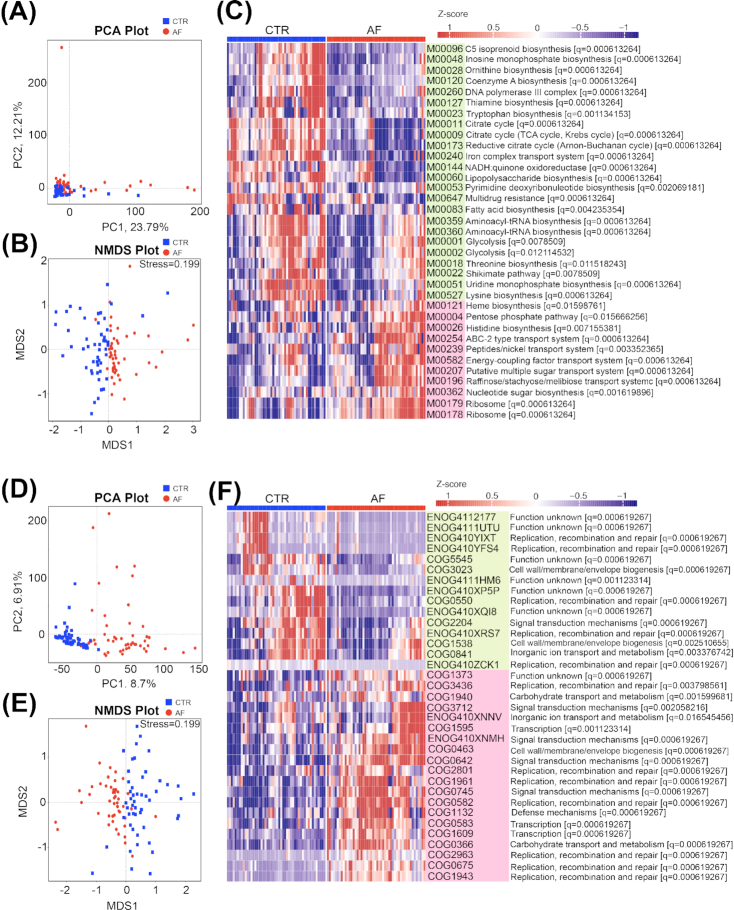
Microbial gene function annotation in AF. A and B, PCA (A) and NMDS (B) based on the relative abundance of KEGG orthology groups in 100 samples showed a significant difference between AF and control (CTR). C, The meanabundance of KEGG modules differentially enriched in the GM of controls and patients with AF. The relative abundance profiles were transformed into z scores by subtracting the mean abundance and dividing the standard deviation of all samples. The z score is negative (shown in blue) when the row abundance is lower than the mean, and red when the row abundance is higher than the mean. Overall, 24 modules enriched in control and 11 modules overrepresented in AF are shown in green and pink, respectively. The physiological effect of KEGG modules and q value are demonstrated on the right; Wilcoxon rank sum test. D and E, PCA (D) and NMDS (E) based on the relative abundance of eggNOG orthologs in 100 samples showed a significant difference between AF and control. F, The mean abundance of eggNOG orthologs differentially enriched in control and AF group. The relative abundance profiles were transformed into z scores by subtracting the mean abundance and dividing the standard deviation of all samples. Thez score is negative (shown in blue) when the row abundance is lower than the mean, and red when the row abundance is higher than the mean. Overall, 15 eggNOGs enriched in control and 20 eggNOGs overrepresented in AF are shown in green and pink, respectively. The potential function of eggNOGs and q value are demonstrated on the right; Wilcoxon rank sum test.